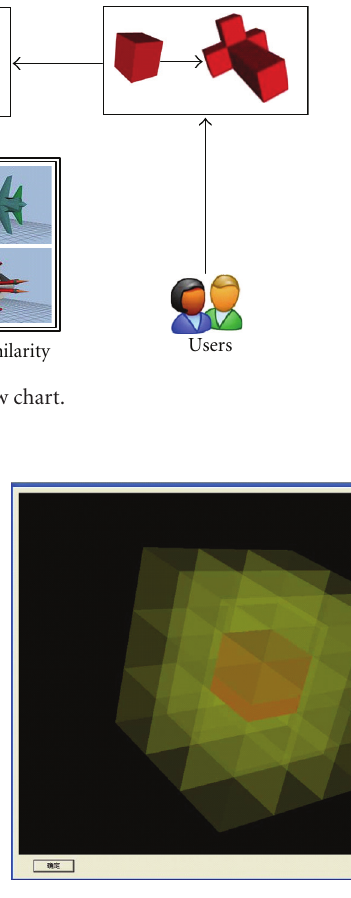
Figure 5: Query model construction